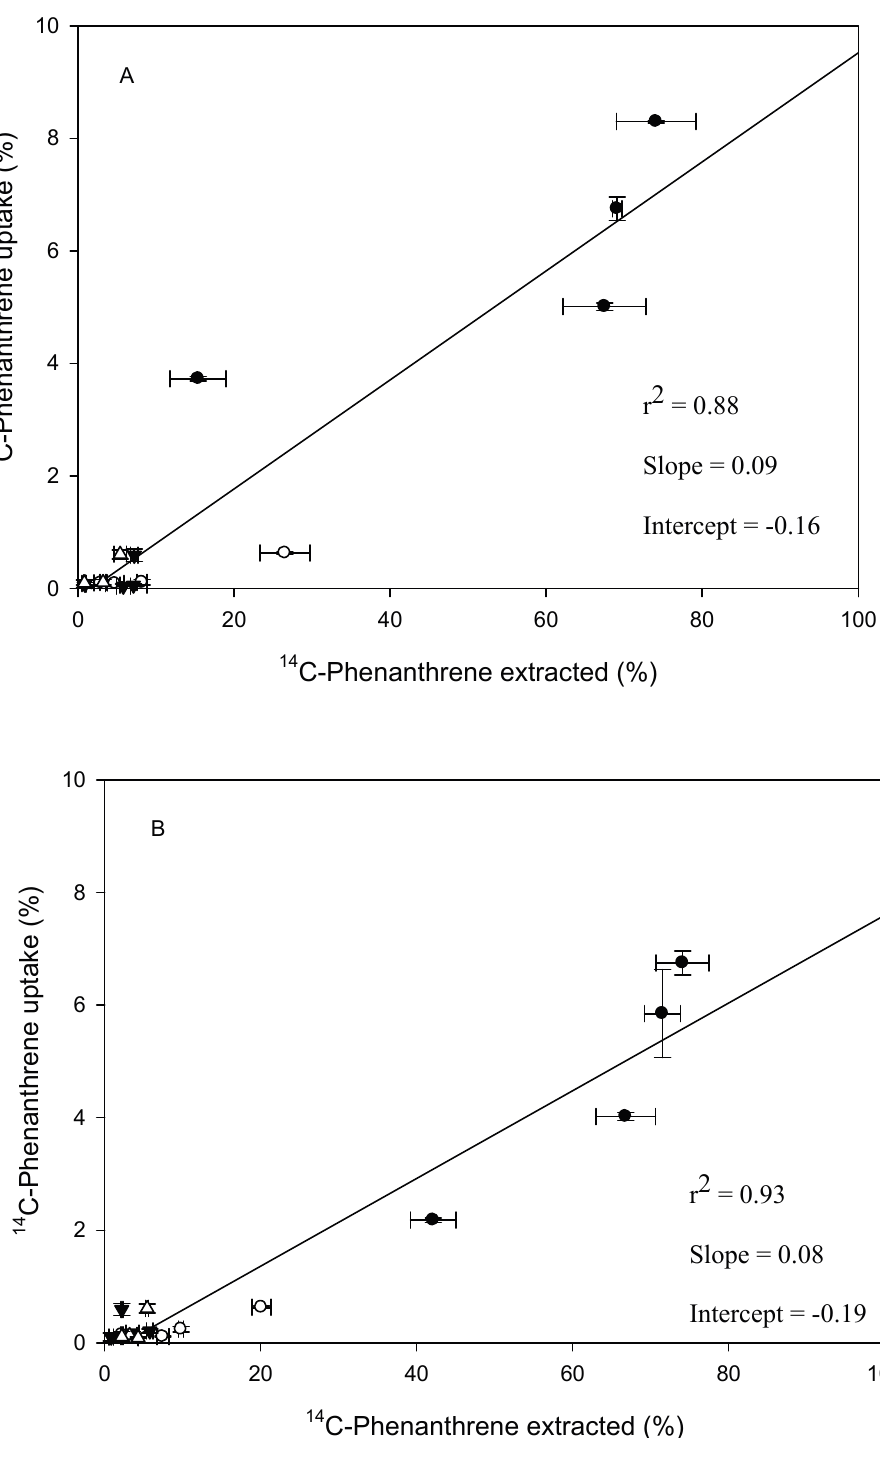
Figure 5. Linear regression showing the correlation between 14 C-phenanthrene uptake by E. fetida and 14 C-phenanthrene extracted by HPCD in ( A ) non-sterile soil ( B ) sterile soil. Data points represent both AC-amended and controls soils Error bars are SEM ( n =